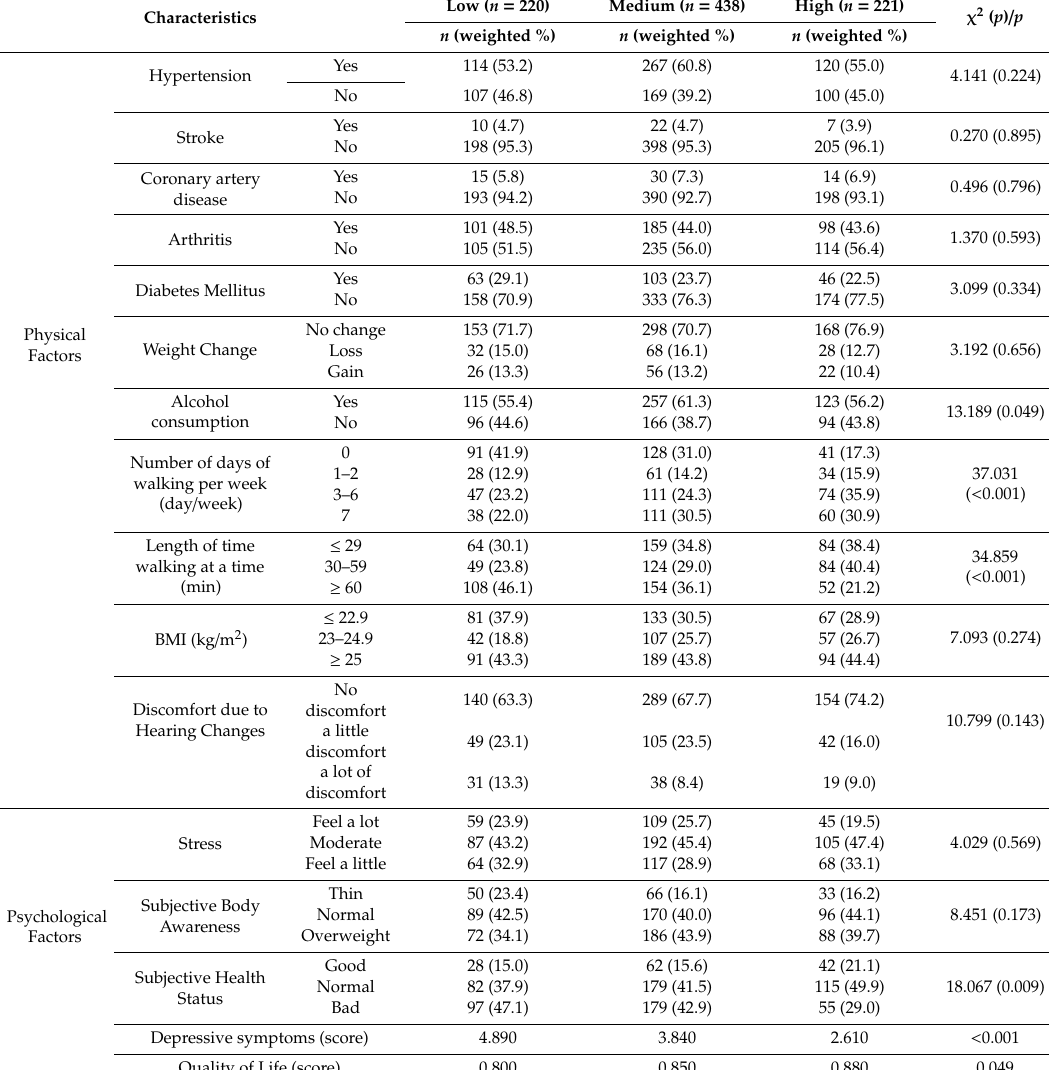
Table 2. Physical and Psychological Characteristics of the